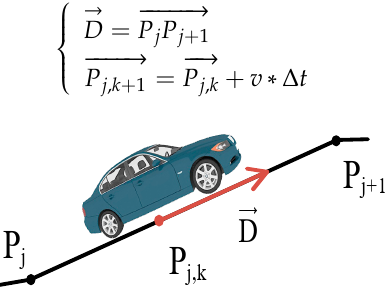
Figure 11. Vehicle animation modeling.